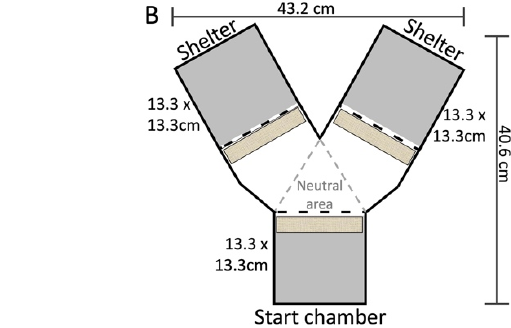
Figure 1. Training and test trial arenas. ( A ) Arena for Experiment 1—within modality ‘sameness’ assay. Dotted lines show the configuration of screens used to prevent contact with the stimuli, while black dashed lines represent the shelter openings. The grey dashed lines demonstrate how the arena was split into thirds to calculate the amount of time the amblypygid spent associating with the C+ and C − stimulus. ( B ) Arena for Experiment 2—Cross modal same/different assay. Same as A, except tan shaded areas represent where stimuli were placed surrounding the doors.